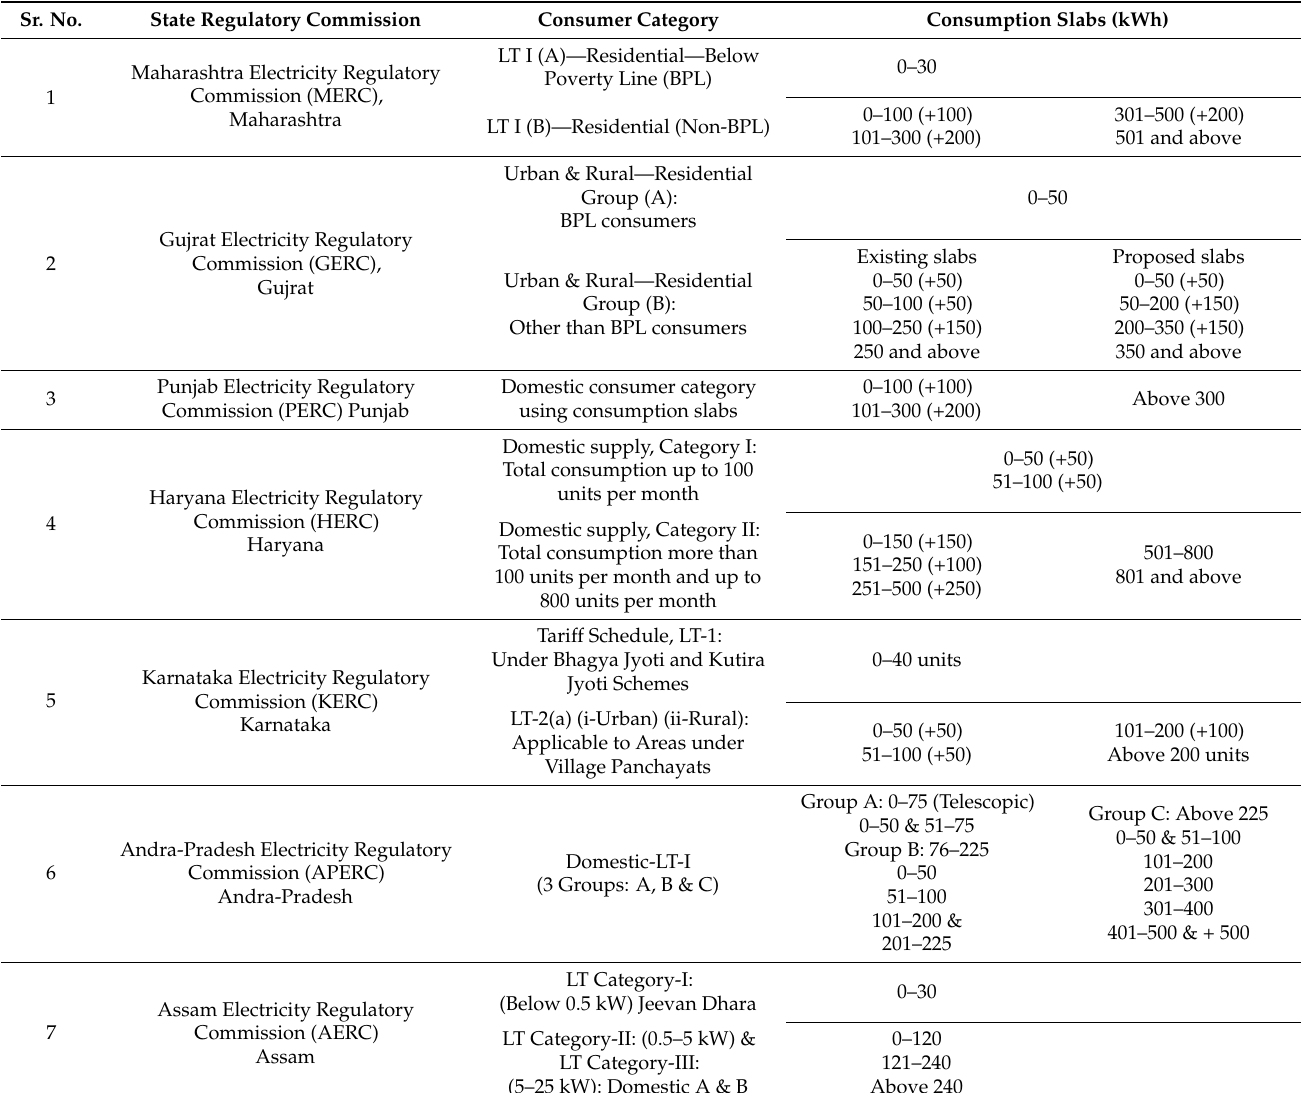
Table 5. Consumption slab-based consumer classification using tariff